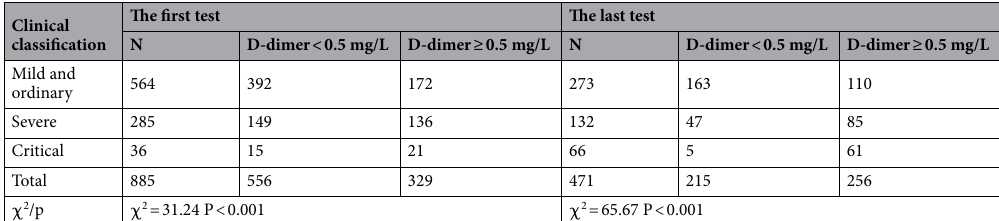
Table 2. Relationship between D-dimer value and clinical classification.